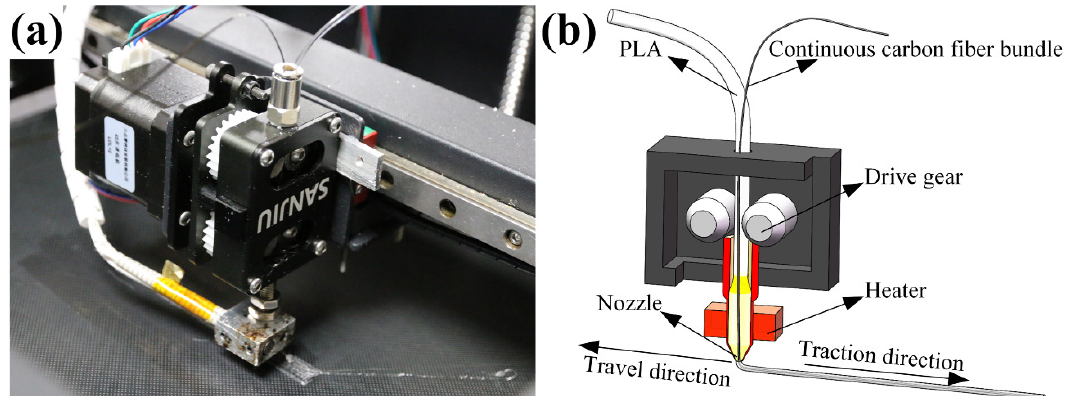
Figure 1. ( a ) Entity diagram and ( b ) structure diagram of 3D printer extrusion head.